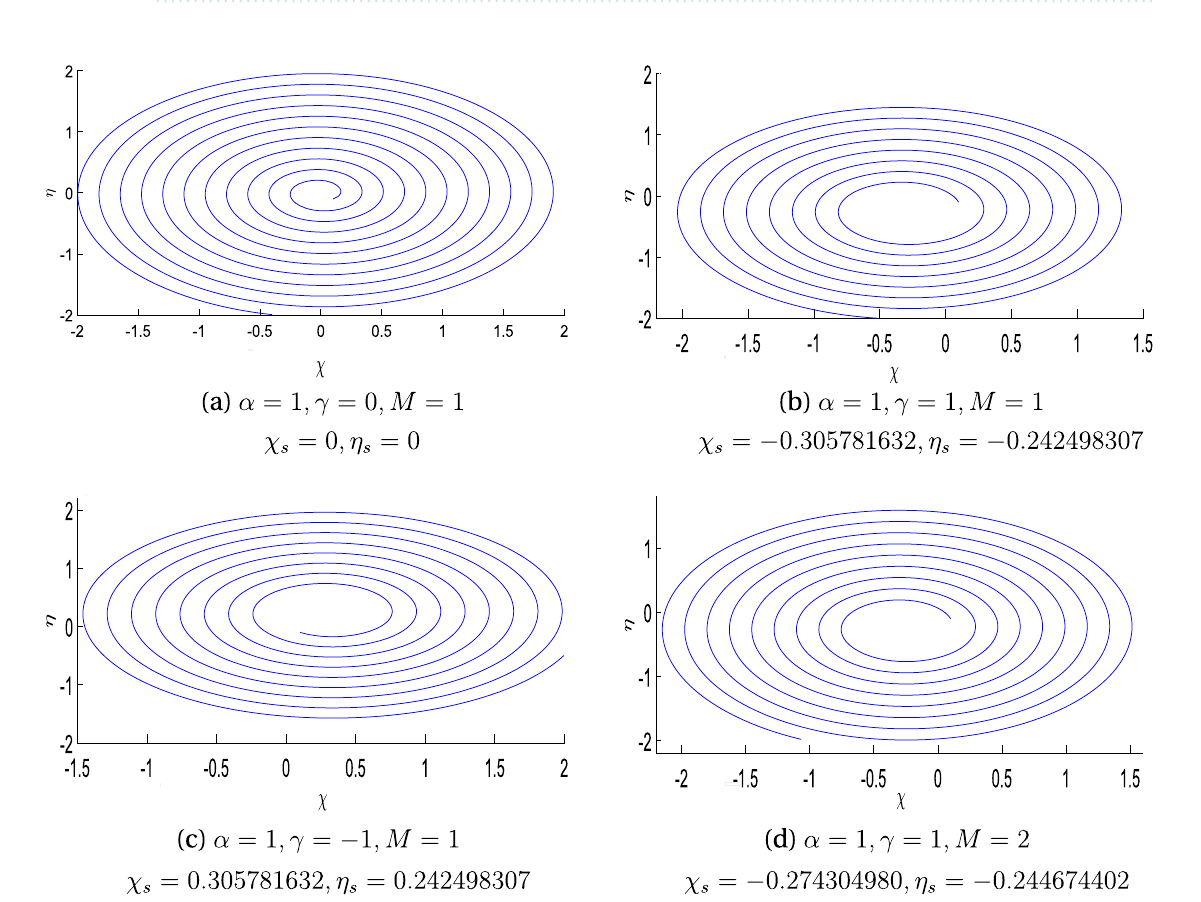
Figure 4. Contours for α = 1 with the variation of obliqueness parameter γ and magnetic parameter